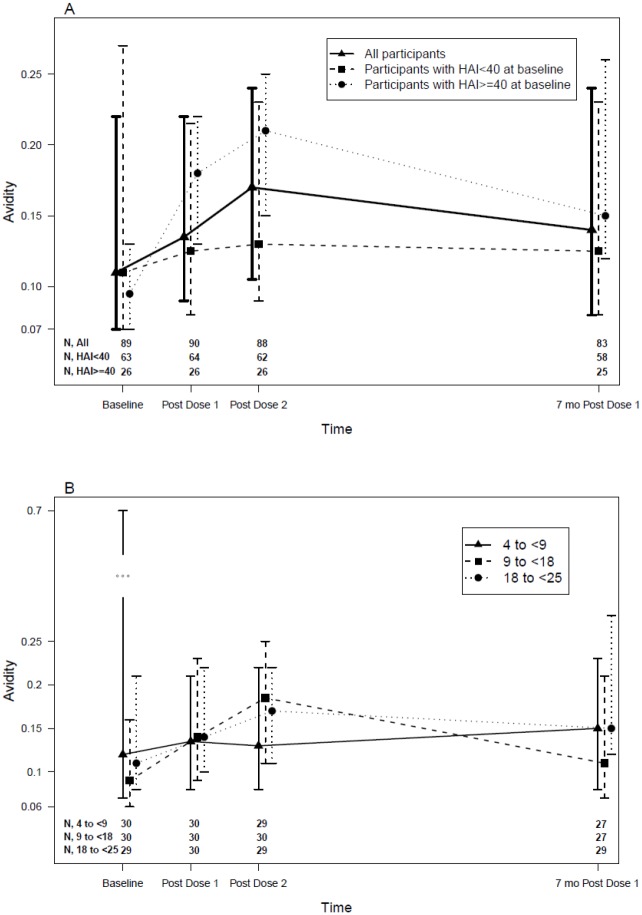
Changes in Antibody Avidity after pH1N1 Vaccination by Age Group and Baseline HAI.Data were derived from HIV-infected children and youth who received 2 doses of pH1N1 monovalent vaccine (30 μg/dose) approximately 3 weeks apart. Data represent medians and Inter Quartile Range (IQR) of the avidity index (AI). The number of subjects per group at each time point is listed on the graph. A presents the AI responses for all subjects and also for the subjects divided by baseline pH1N1 HAI immune serostatus (HAI titer <1:40 versus ≥1:40). Overall, AI significantly increased post-dose 2 (p = 0.04) and remained slightly higher at 7 mo (p = 0.07). Only subjects seroprotected at baseline had significant AI increases after vaccination (p<0.0001, <0.0001 and 0.003 post-dose 1, post-dose 2 and 7 months post-dose 1, respectively). Baseline seropositive participants with HAI titers ≥ 1:40 had a significantly higher AI response to vaccination compared with participants with baseline HAI titers <1:40 (p = 0.02 at both post-dose 1 and post-dose 2). B shows AI responses in each age group. In the 4 to <9-year old group, there were no significant differences in AI between baseline and any subsequent time point. In the 9 to <18-year old group, there were significant AI increases at post-dose 2 and at 7 months (p = 0.04 and 0.048 respectively). In the 18 to <25-years old group, there were significant differences from baseline at all time points (p = 0.02, 0.04 and 0.002, respectively).